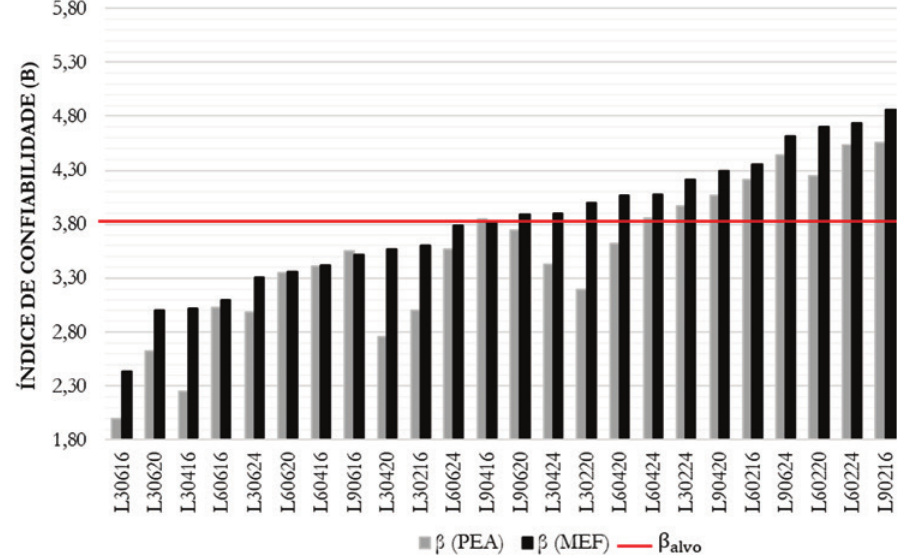
Figura 5 Índices de confiabilidade alcançados pelas lajes lisas